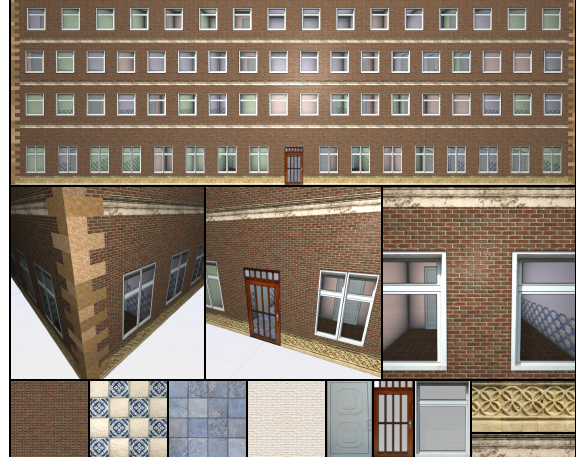
Figure 1: Rendering of a procedural facade texture applied to a single quad (upper image). Close ups of the facade demon- strate the high quality of our textures that even give the impres- sion of 3D rooms behind the windows (middle row). A selection of atomic texture elements, which were used to compose this ex- ample facade, are shown in the bottom